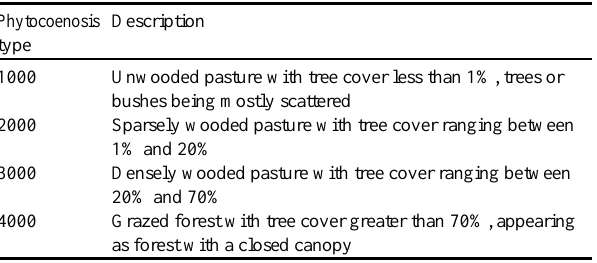
Table 3 . Definition of the four main phytocoenosis types for structural classification of pasture-woodland vegetation (Gallandat et al.